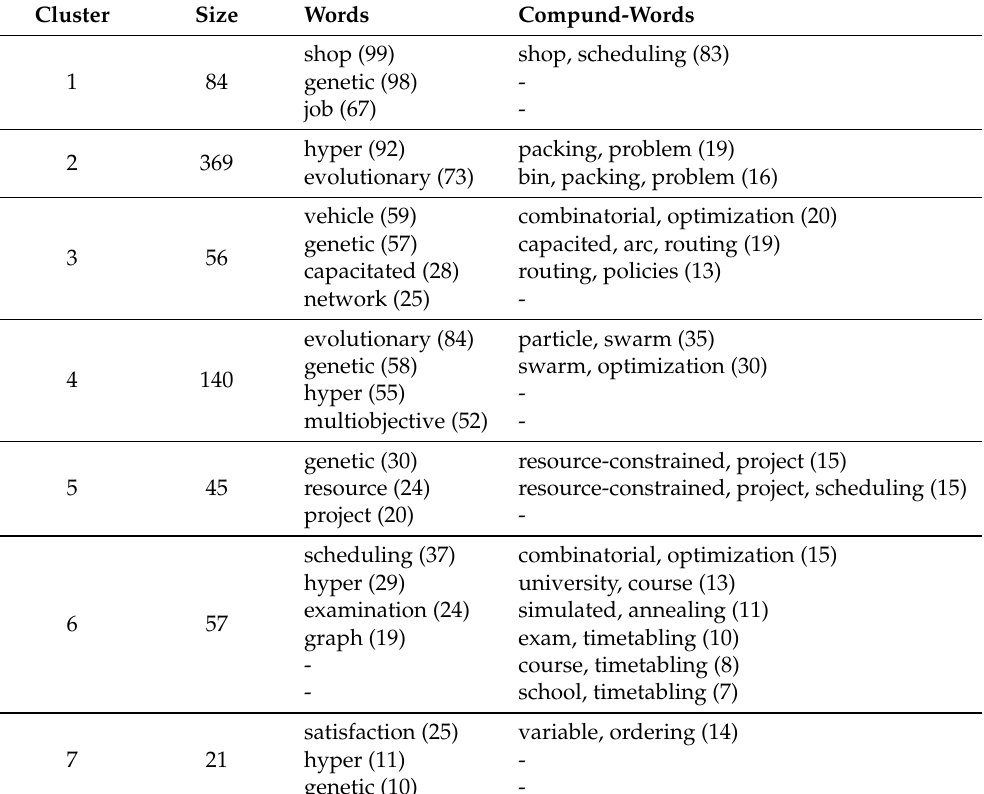
Table 2. Clusters related to hyper-heuristics in the literature. The count of each word or compound word is illustrated between